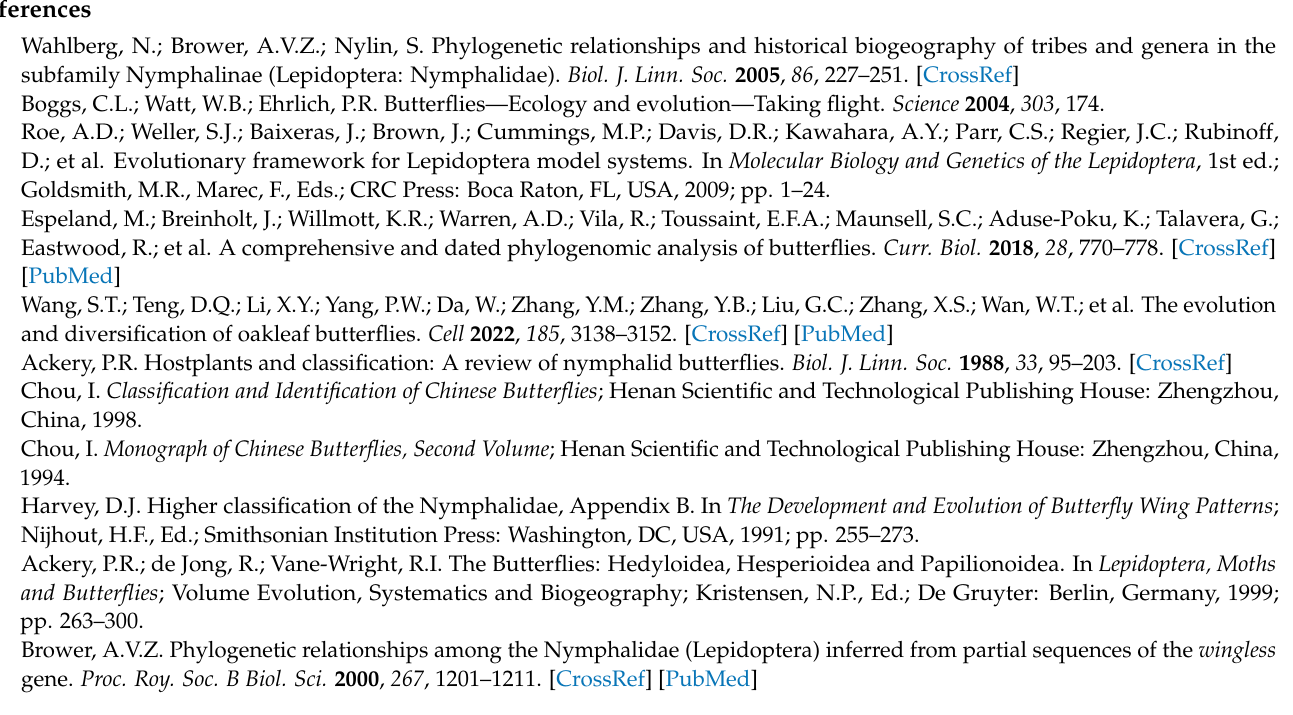
Table S4: The PCR reaction system; Table S5: Best partitioning scheme and nucleotide substitution models for different datasets selected by PartitionFinder; Table S6: Mitogenomic organization of Doleschallia bisaltide